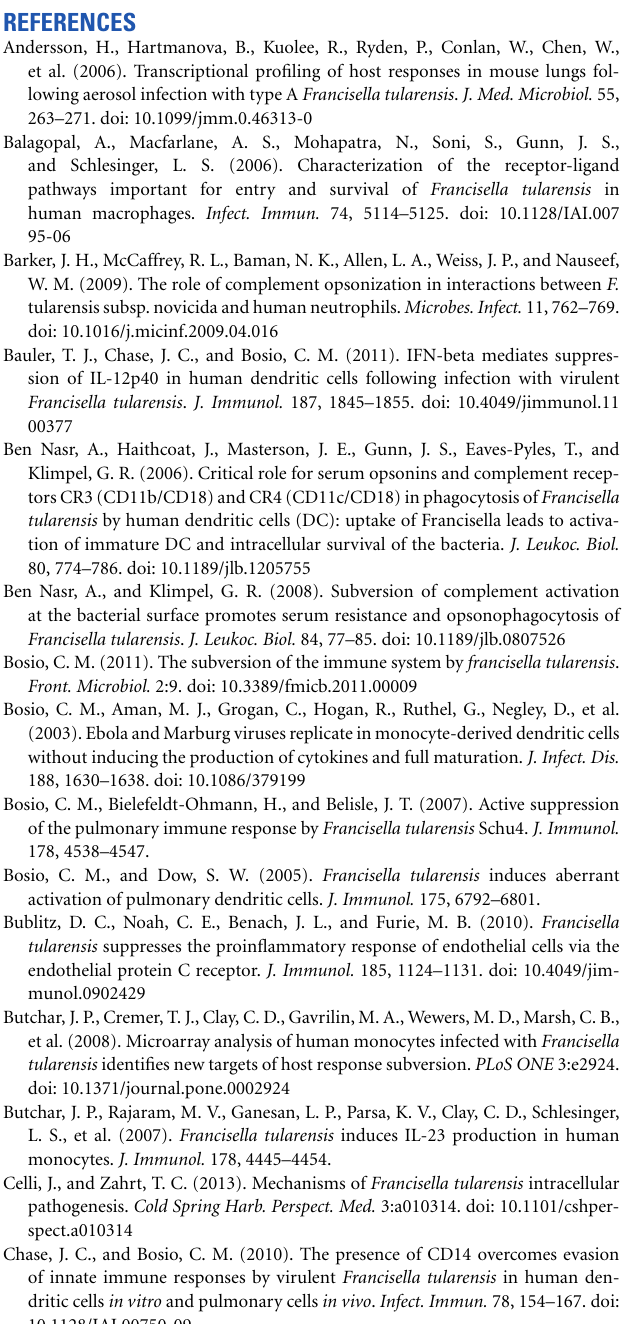
Supplementary Figure 3 | Differential effect of Francisella on expression of selected genes in human monocytes. Primary human monocytes infected overnight (16 h) with F. novicida (Fn), F. tularensis (Ft), or both at an MOI of 50 for each bacteria were analyzed for expression levels of RELA , IKBIA, PSTPIP1 and PYCARD genes. Data are expressed as mean ± s.e.m., n = 3 independent